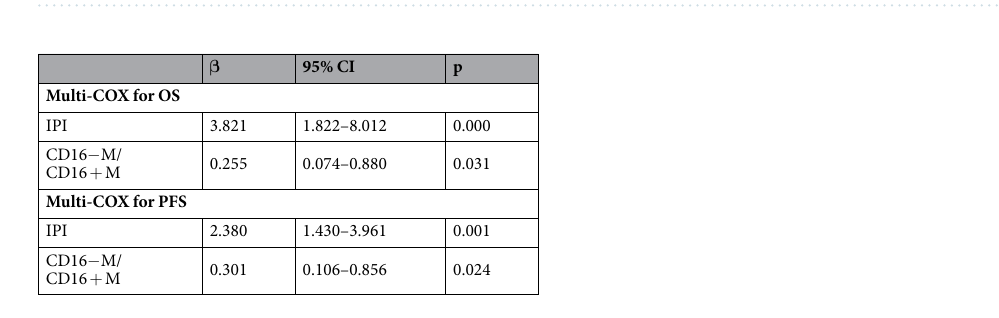
Table 3. Prognostic models for OS and PFS constructed with IPI and CD16 − /CD16 + monocyte